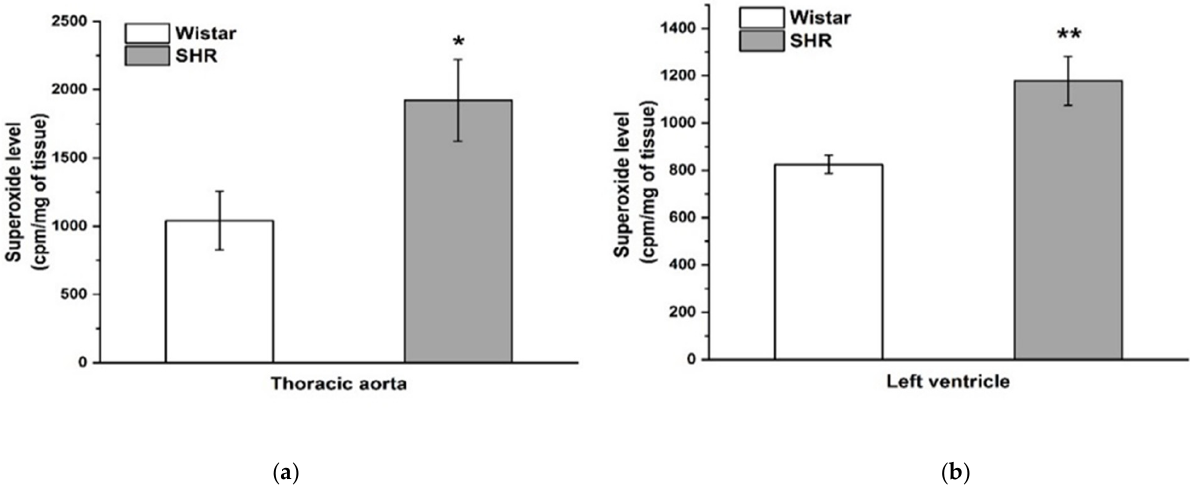
Figure 4. The production of superoxide in the thoracic aorta ( a ) and left ventricle ( b ) in Wistar and spontaneously hypertensive rats. The results are presented as the mean ± S.E.M., and differences between groups were analyzed by Student’s t-test. * p < 0.05, ** p < 0.01 vs. Wistar.